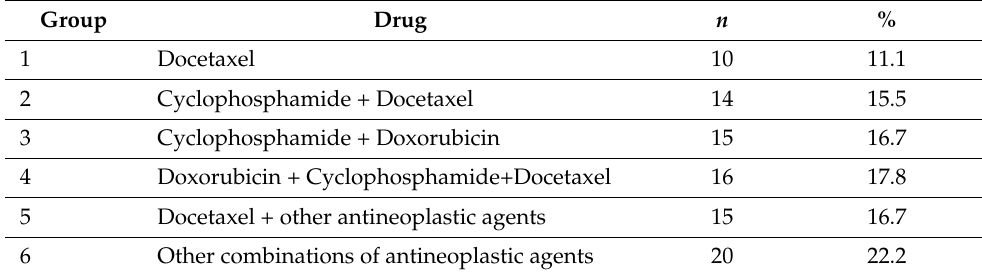
Table 3. Results of the most frequent antineoplastic agents in the study sample.